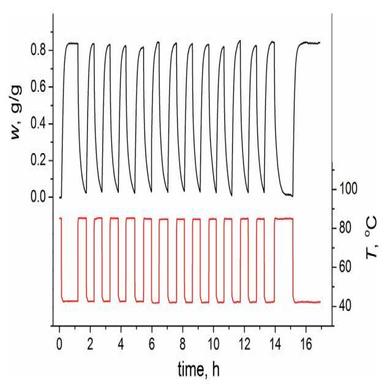
Evolution of the water uptake (top) and the temperature of the metal support (bottom) during the cycle testing. P(H2O) = 17.2 mbar.